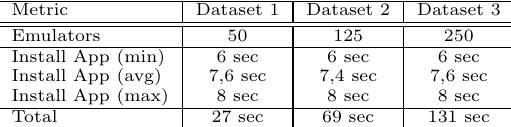
Figure 10: Deployment network bandwidth. Table 2: Application deployment time.